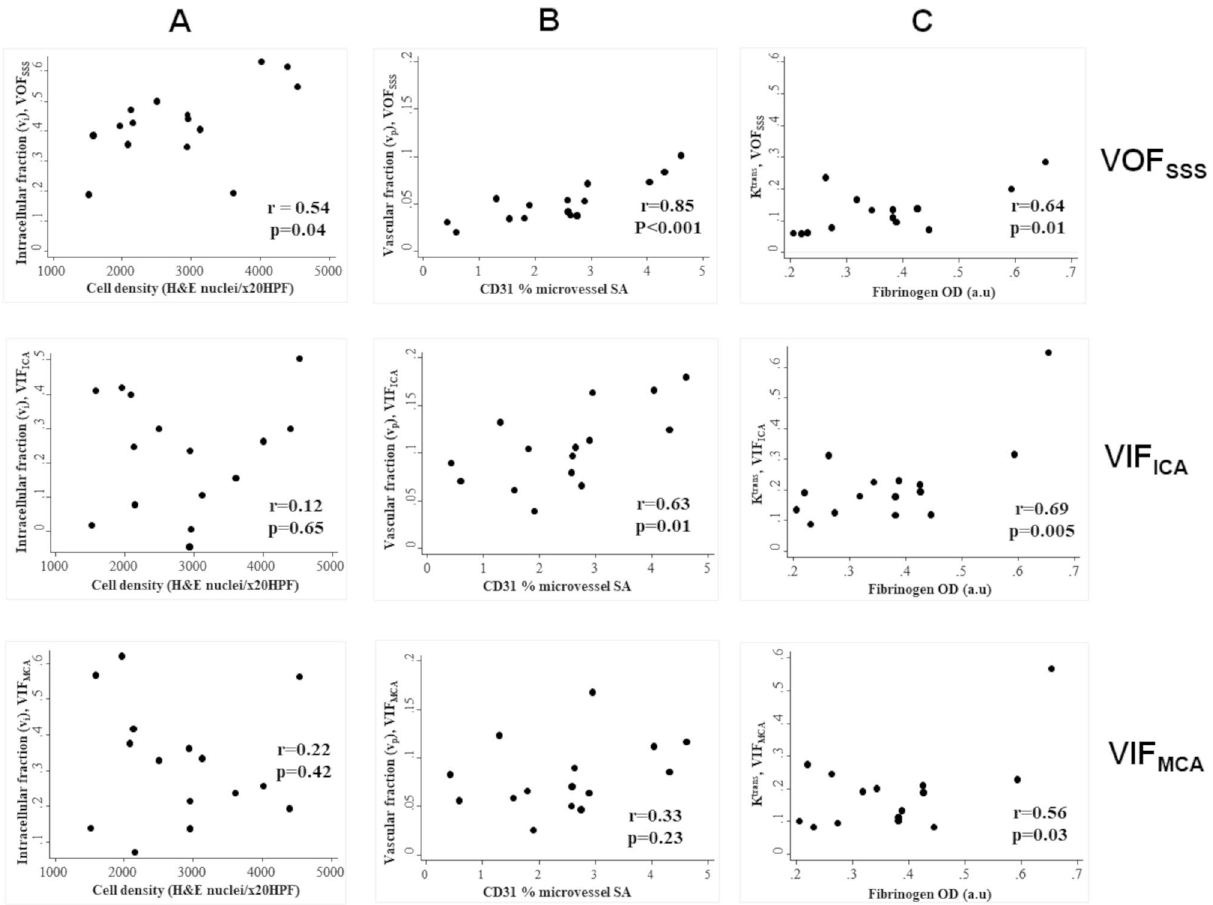
Figure 5. Scatterplot comparison of histopathological data with kinetic parameter estimates (v i , v p , K trans ) derived using different VOF/VIF approaches. ( A ): Intertumour scatterplot comparison of mean tumour intracellular fraction ( v i , no units) estimates against mean H&E cell density (nuclei/ x20HPF). v i estimates derived using VOF SSS ( top row ), VIF ICA ( middle row ) and VIF MCA ( bottom row ) shown. ( B ) Intertumour scatterplot analysis of mean vascular fraction ( v p, no units) against mean CD31% microvessel surface area (SA). v p estimates derived using VOF SSS ( top row ), VIF ICA ( middle row ) and VIF MCA ( bottom row ) shown. ( C ) Intertumour scatterplot analysis of mean tumour K trans (min -1 ) against mean fibrinogen optical density (OD). K trans estimates derived using VOF SSS ( top row ), VIF ICA ( middle row ) and VIF MCA ( bottom row )